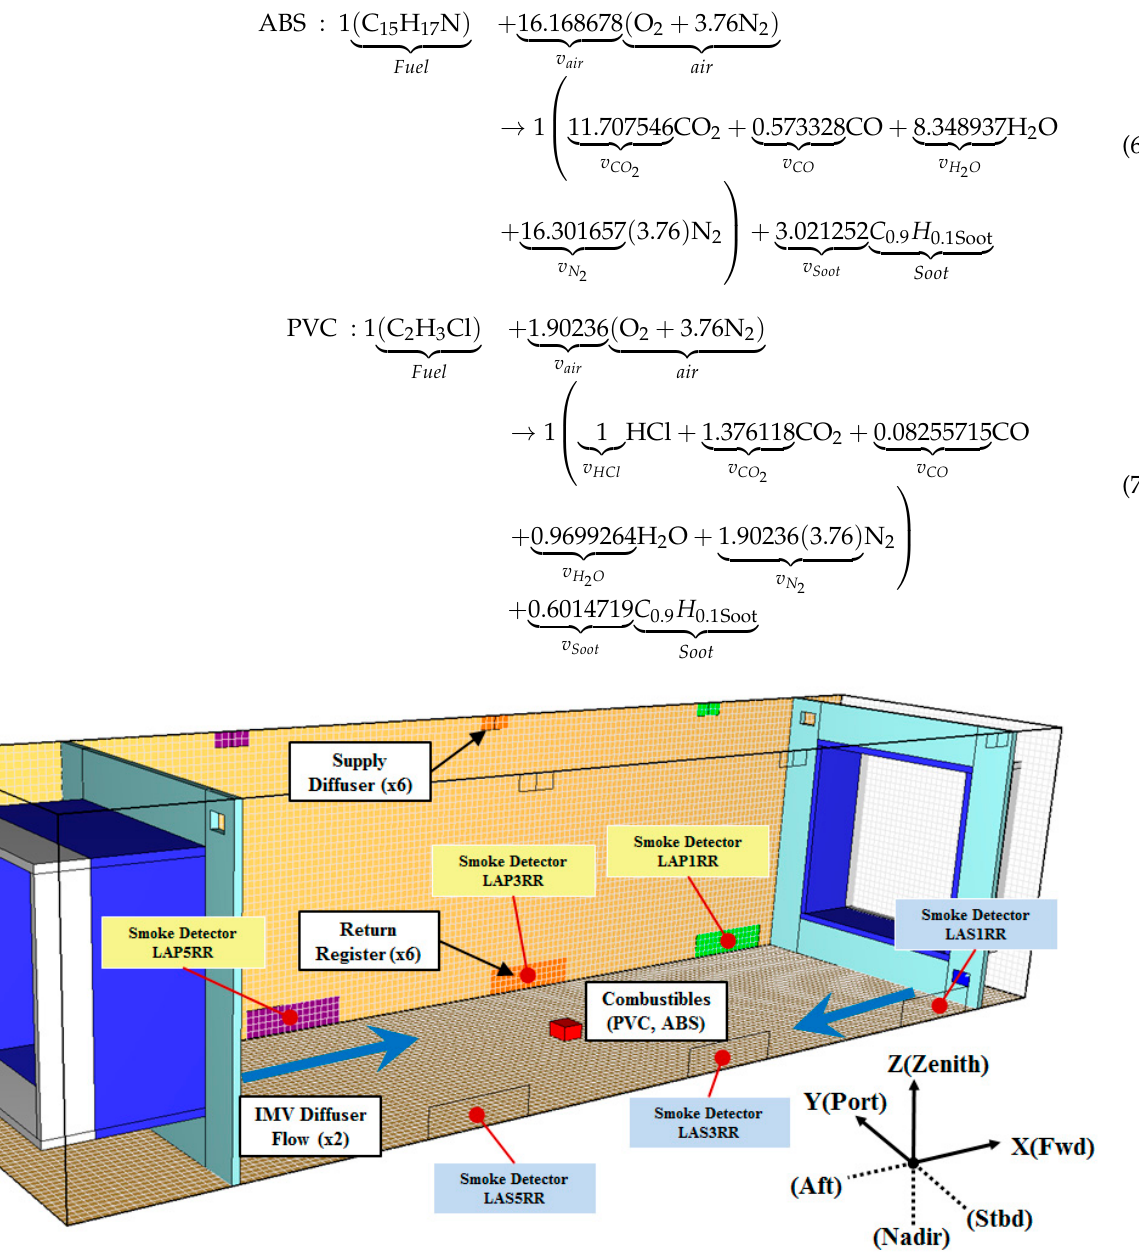
Figure 2. Cone calorimeter results as a function of time: ( a ) mass-loss rate; ( b ) CO yield; ( c ) specific extinction area. Table 1. Summary of soot and CO yields and effective heat of combustion for ABS and PVC combustibles.